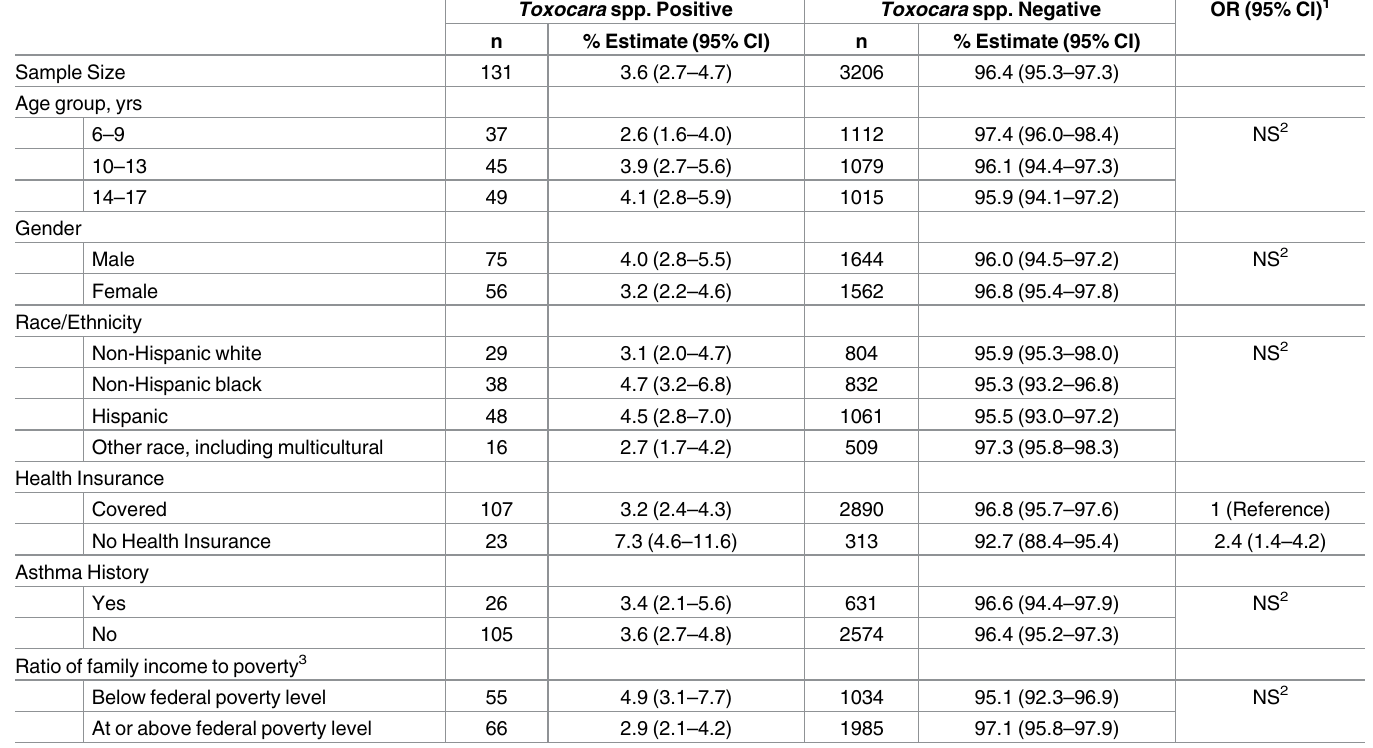
Table 1. Characteristics associatedwith Toxocara spp. infection in children.